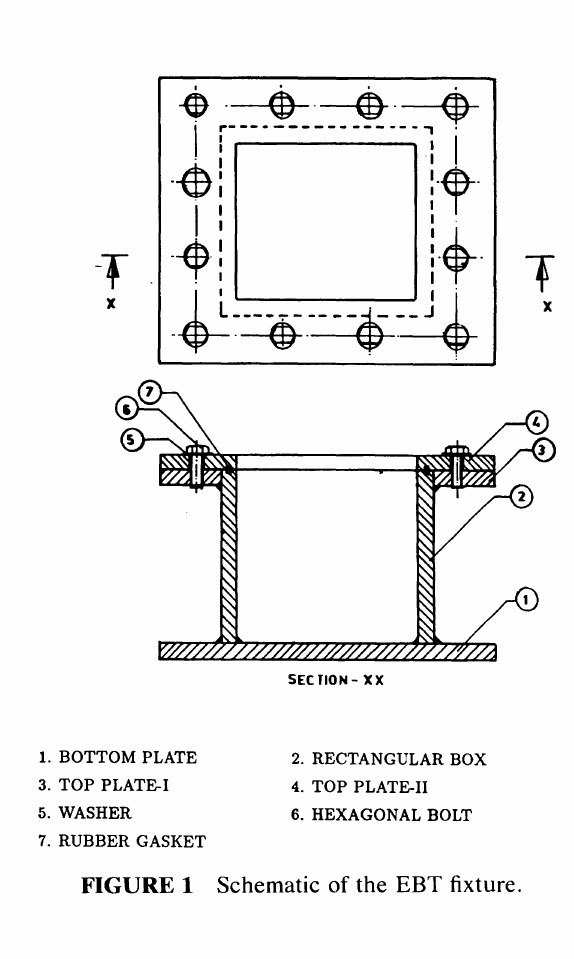
tween top plate I and II with an exposed area of 300 x 250 mm and clamped with case hardened bolts and nuts. A rubber gasket was provided between the top plate-l and the test plate to pre vent water leaking into the assembly. The photo graphic view of the assembly is shown in Fig. 2.